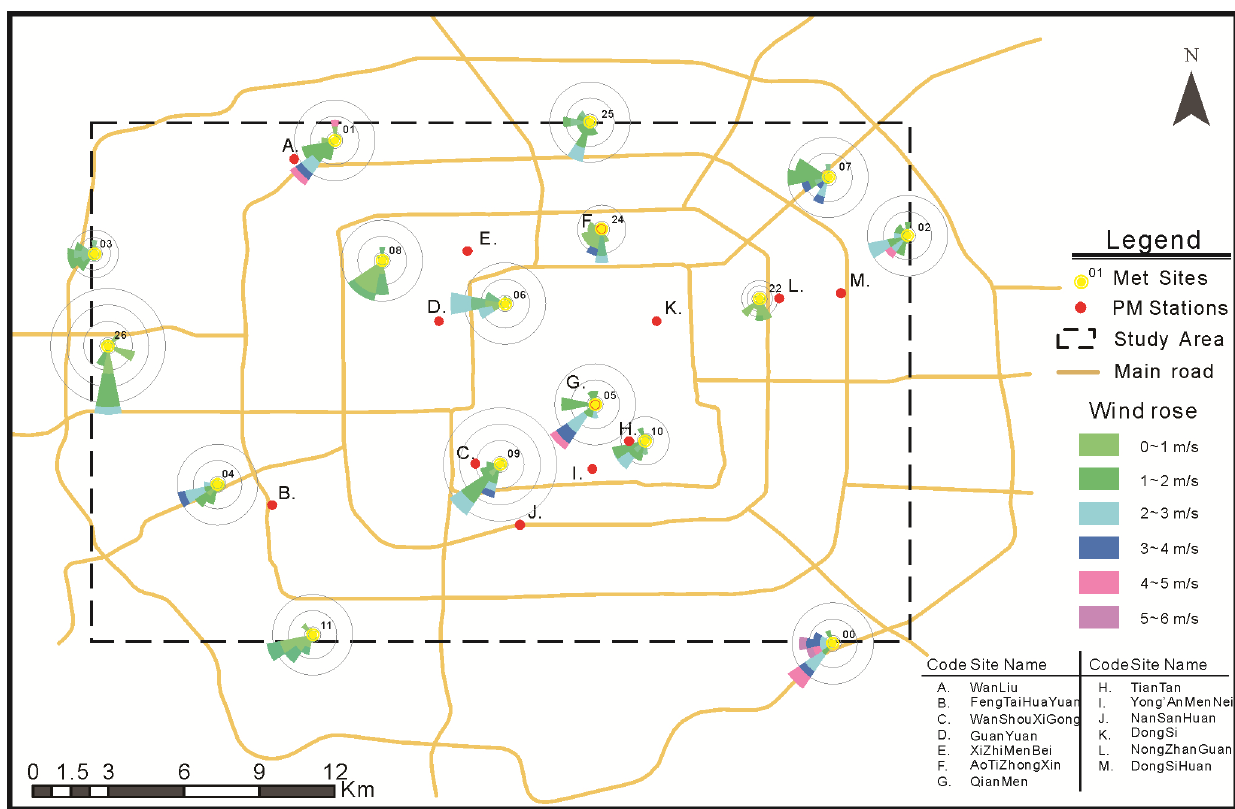
Figure 1. Study area and locations of PM 2.5 monitoring stations and meteorological sites with daily wind roses for May 18 th .